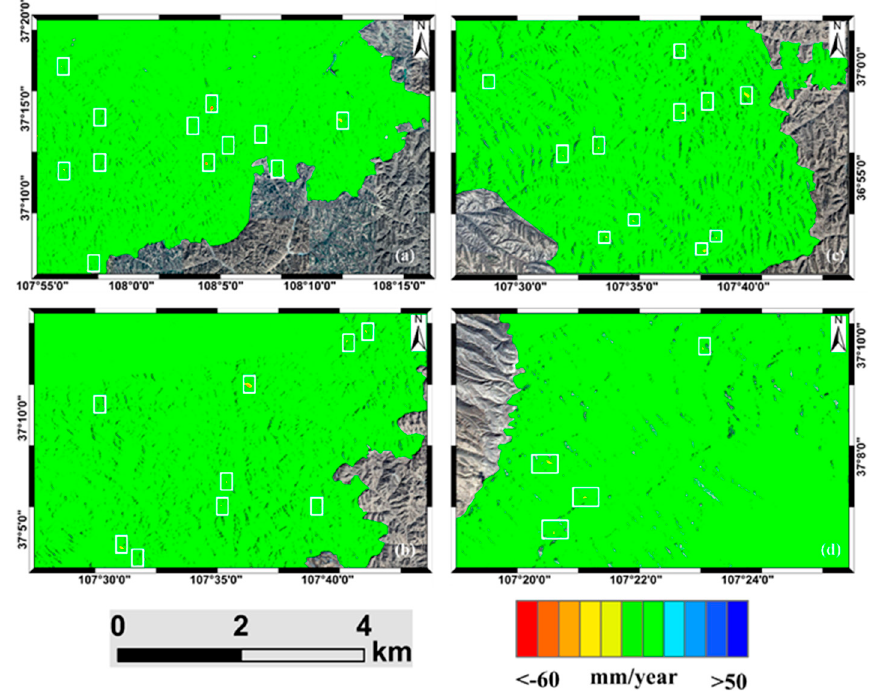
Figure 7. Enlarged annual-deformation-rate maps of four regions: ( a ) Zone 1; ( b ) Zone 2; ( c ) Zone 3; ( d ) Zone 4 (marked in Figure 6), where the white rectangles indicate individual landslides.